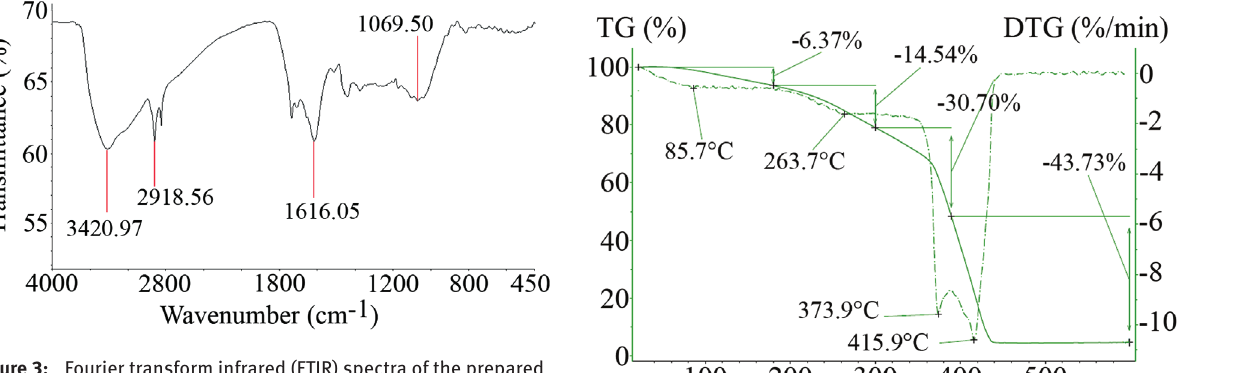
Figure 3: Fourier transform infrared (FTIR) spectra of the prepared INPs, indicating presence of organic compounds from Pinus eldarica .